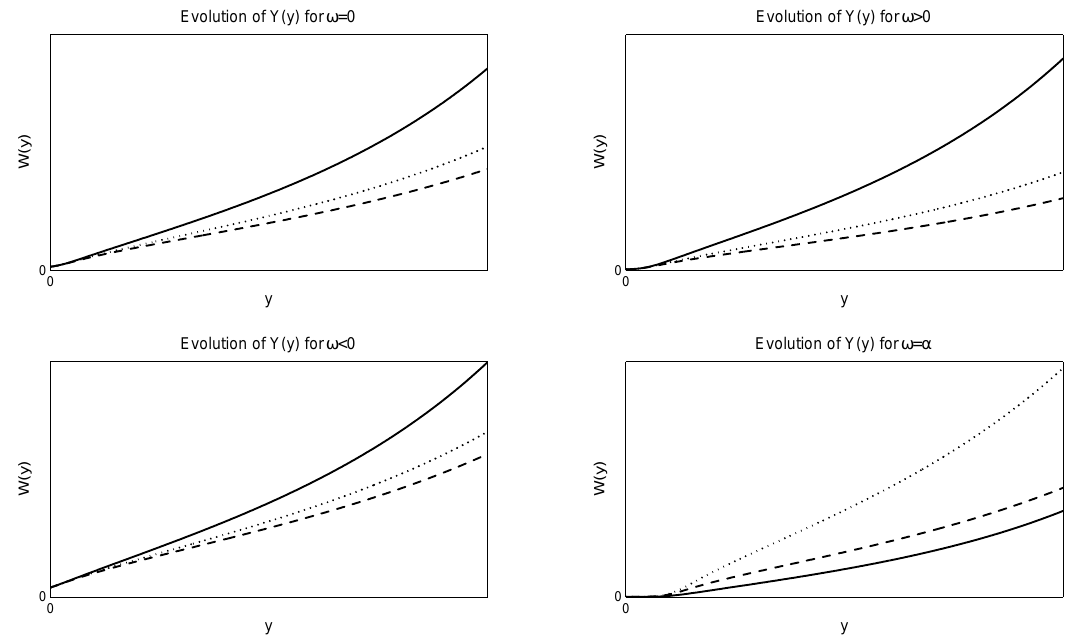
Figure 4. Evolution of the solution Equation (56) of the Stein–Stein model. For the numerical solutions, we select β = 0.5, r = 0.5, κ 1 = 1 and κ 2 = 1.01. The figures are for ω = 0, ω = 0.5, ω = − 0.5 and ω = α , respectively. The solid lines are for α = 1.1, the dotted lines are for α = 1.3 and the dash-dash lines are for α =